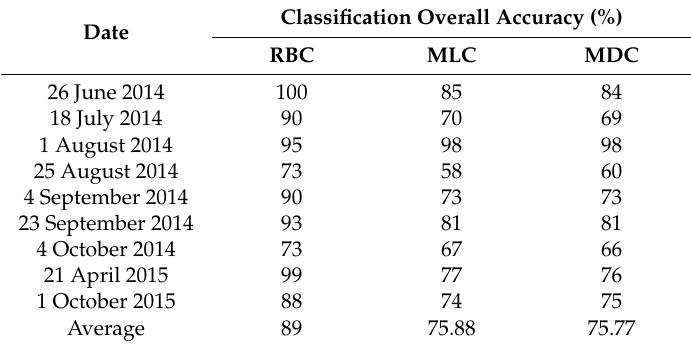
Table 4. Overall accuracies of the different scan dates determined with confusion and error matrices.